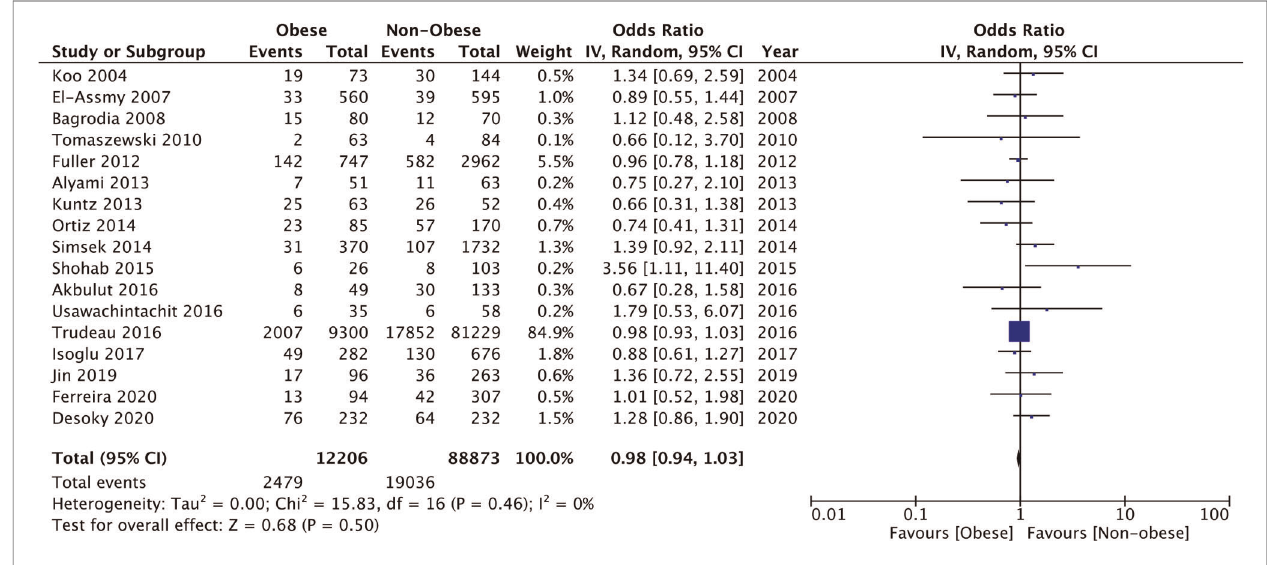
FIGURE 7 | Meta-analysis of complication rates between obese vs non-obese patients.